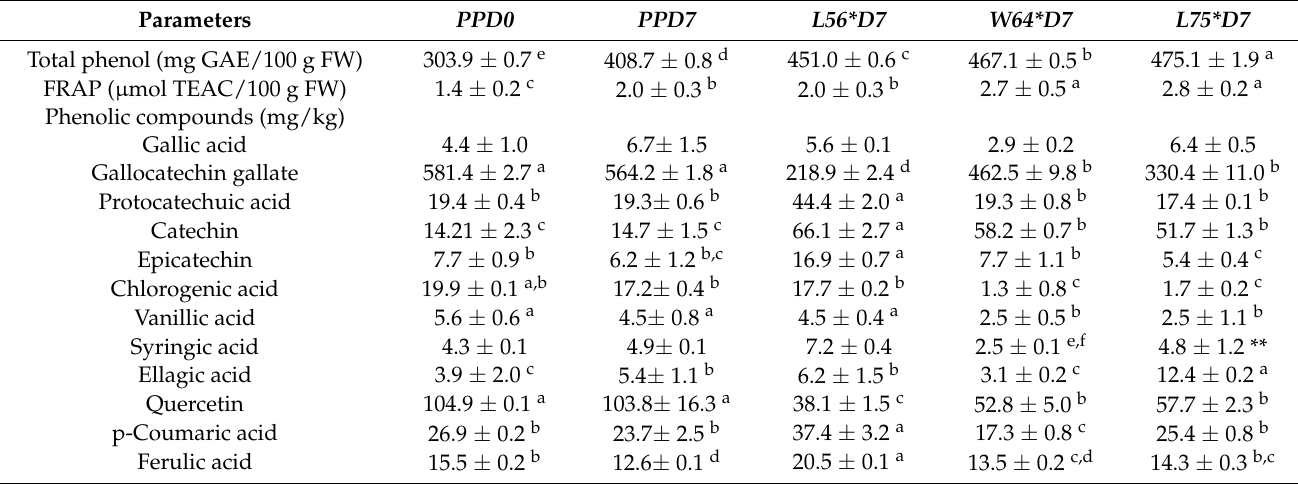
Values are mean ± standard deviation, and means followed by a different letter within the row are significantly different ( p ≤ 0.05); values within the brackets show % increase or reduction in respective phenolic compounds. Key: PPD0 = non-fermented papaya puree at 0 days; PPD7 : non-fermented papaya puree stored at 4 ◦ C for 7 d; L56*D7 : papaya puree fermented with Leu. pseudomesenteroides 56 stored at 4 ◦ C for 7 d; W64*D7 : papaya puree fermented with W. cibaria 64 stored at 4 ◦ C for 7 d; L75*D7 : papaya puree fermented with Lpb. plantarum 75 and stored at 4 ◦ C for 7